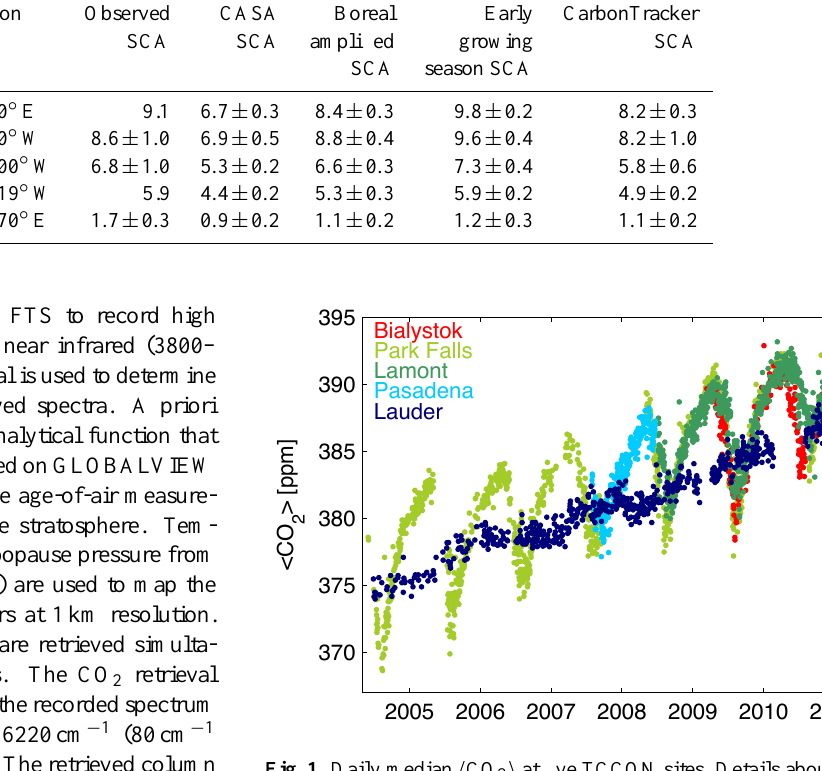
Fig. 1. Daily median h CO 2 i at five TCCON sites. Details about the location and operational dates for each site are provided in Table